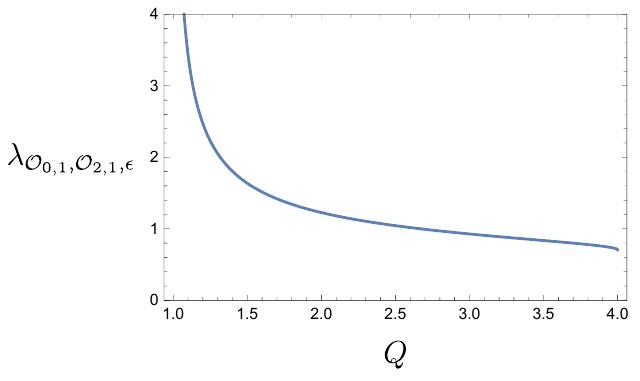
Figure 4. The OPE O 0 ; 1 " contains the (cid:12)eld O 2 ; 1 which is part of a level two staggered module. We plot here the OPE coe(cid:14)cient. In a small z; (cid:22) z expansion, the h " (0) O 0 ; 1 ( z; (cid:22) z ) O 0 ; 1 (1) " ( 1 ) i four point function will have logarithms of z (cid:22) z with prefactors proportional to (cid:21) 2 of S and has multiplicity Q ( Q (cid:0) 3) Q